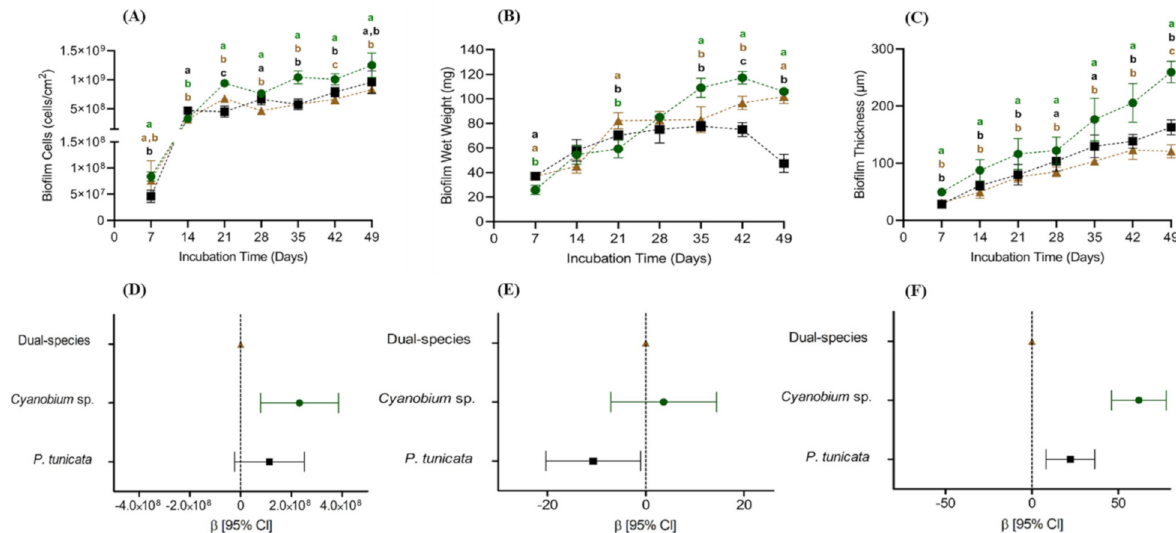
Figure 1. ( A – C ) Single- and dual-species biofilm formation on gel-coated glass surfaces for 49 days: • — Cyanobium sp. LEGE 10375, (cid:4) — Pseudoalteromonas tunicata, and (cid:78) — Pseudoalteromonas tunicata–Cyanobium sp. LEGE 10375. The biofilm parameters are ( A ) number of cells, ( B ) wet weight, and ( C ) thickness. Letters were assigned in alphabetic order from the highest to the lowest value (from a to c) for each time point. These assignments were made as long as statistically significant differences existed between the biofilms with a confidence level greater than 95% ( p < 0.05). The color of the letters allows for association with the type of biofilm formed (green— Cyanobium sp. LEGE 10375, black— Pseudoalteromonas tunicata, and brown— Pseudoalteromonas tunicata–Cyanobium sp. LEGE 10375). The means ± SDs for three independent experiments are illustrated. ( D – F ) Association between the ( D ) number of biofilm cells, ( E ) wet weight, and ( F ) thickness, and single- and dual-species biofilms. Dual-species biofilms were used as the reference condition. Linear regression models were adjusted for incubation days. Results are represented as beta estimates ( β ) and the corresponding 95% confidence interval (95%